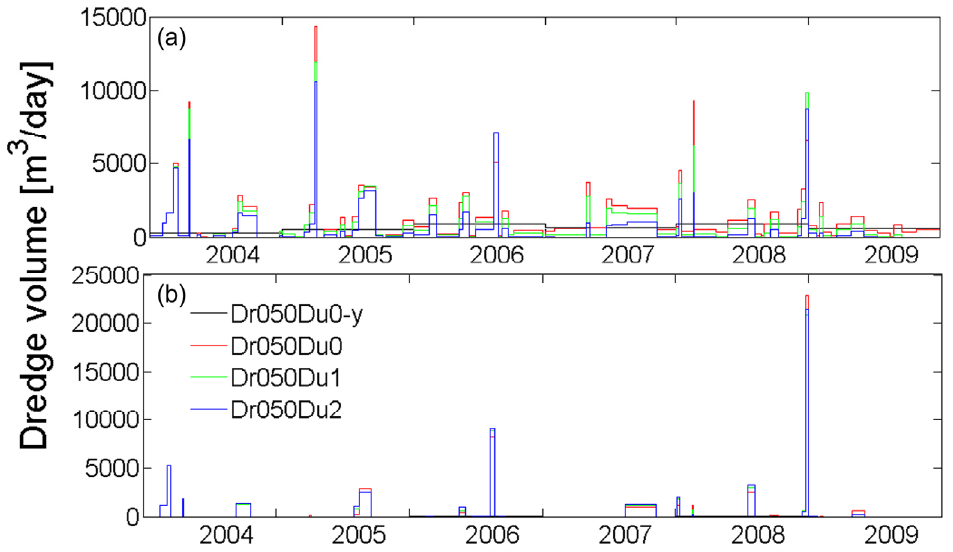
Figure 9. Dredging time series showing three dredging strategies (where for Du0 also the “yearly Q ” hydrograph is included) ( a ) in Bella Vista km 448–453 and ( b ) Borghi km